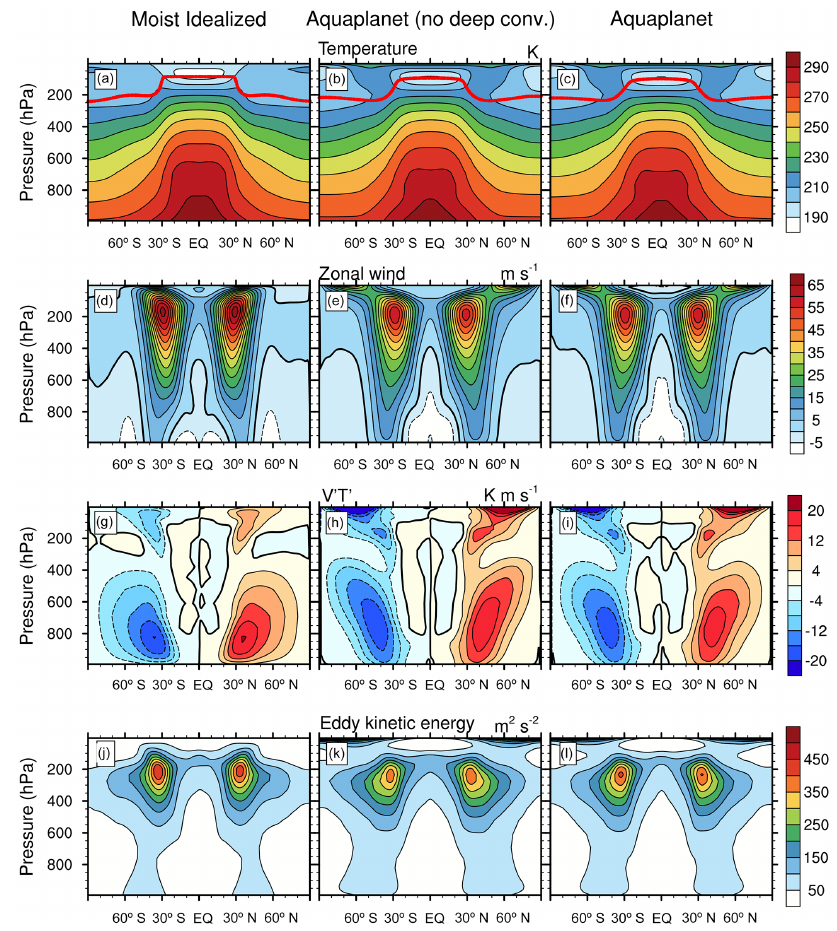
Figure 1. Comparison of CAM5-SE latitude–pressure cross sections in MITC (left column), APS (NDC) (middle column), and APS (right column): Time-mean zonal-mean (a, b, c) temperature, (d, e, f) zonal wind, (g, h, i) meridional eddy heat flux v (cid:48) T (cid:48) , and (j, k, l) eddy kinetic energy. The red line in (a, b, c) indicates the position of the